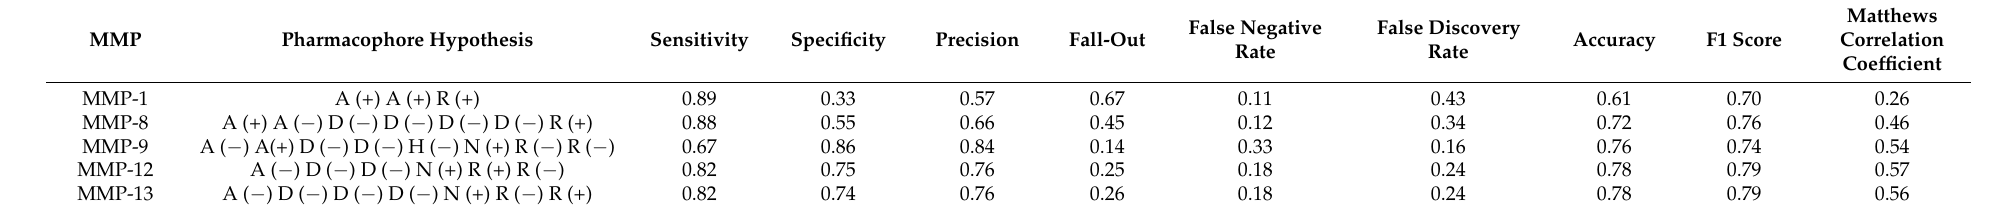
Table 3. Pharmacophore hypotheses selected for each MMP and statistical parameters obtained in their validation. The letters “A”, “D”, “R” and “N” stand for acceptor, donor, aromatic and negative pharmacophoric features, respectively, and the symbols “+” and “ − ” indicate whether they match the pharmacophoric site or